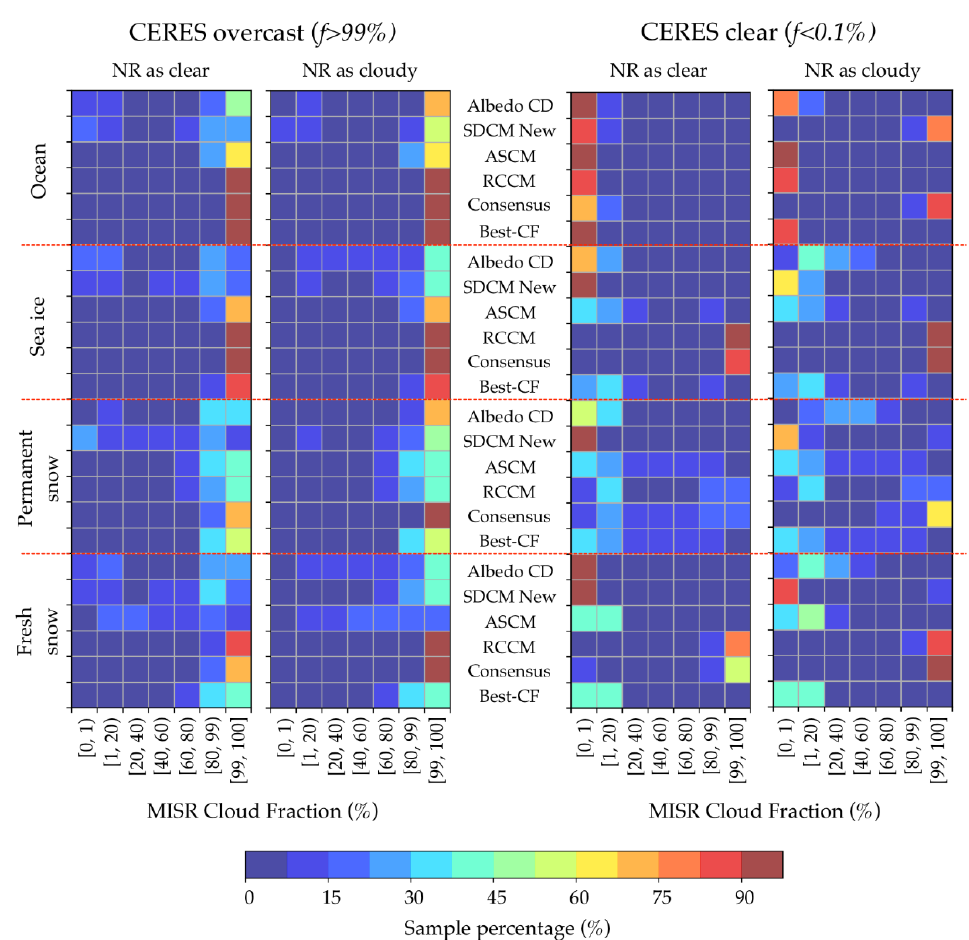
Figure 6. Sample distribution of collocated (20 km) 2 CERES-MISR samples for six MISR cloud masks (Albedo Cloud Designation (CD), Stereoscopically Derived Cloud Mask (SDCM) new, Angular Signature Cloud Mask (ASCM), Radiometric Camera-by-Camera Cloud Mask (RCCM)-An, Consensus, Best-CF) over CERES overcast ( f > 99%), and clear ( f < 0.1% ) scenes by treating No Retrieval (NR) cloud mask values as clear and as cloudy. Note that both ASCM and RCCM are terrain- referenced.